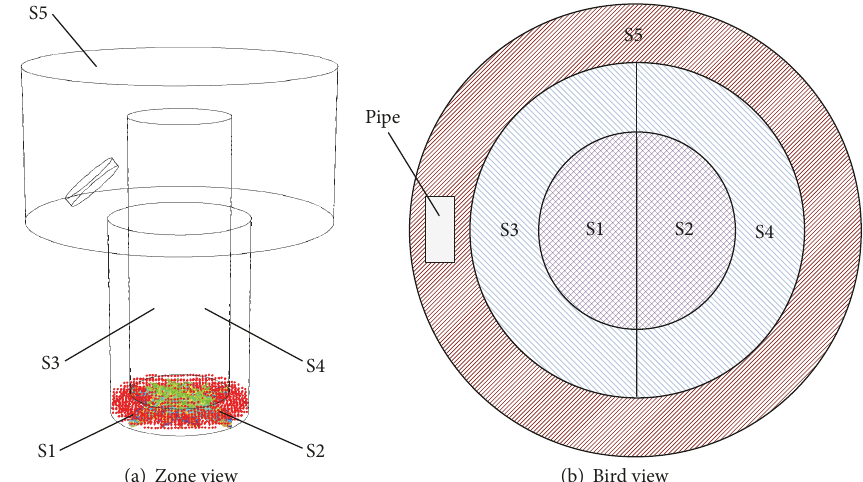
Figure 20: Schematics of debris domain (moves from the top to the